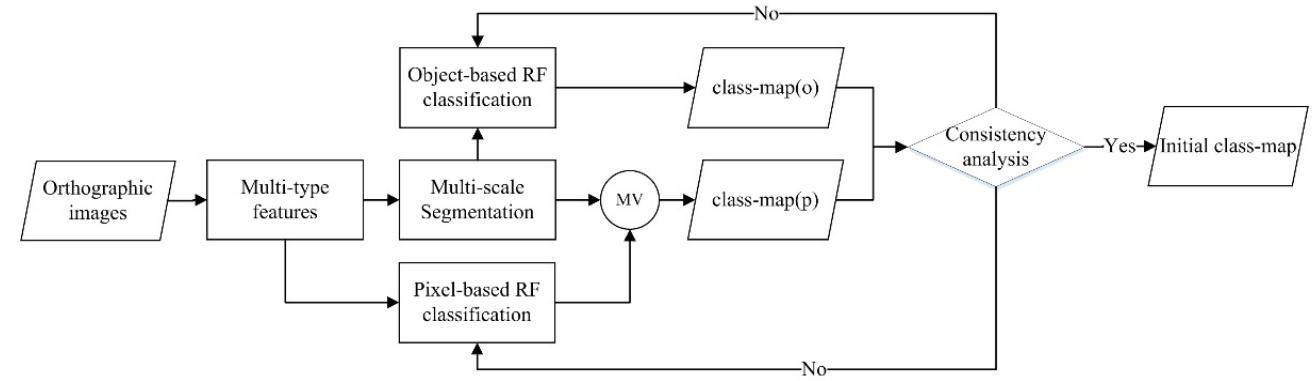
Figure 3. Flowchart of a pixel- and object-based framework for intra-city land-cover classification.